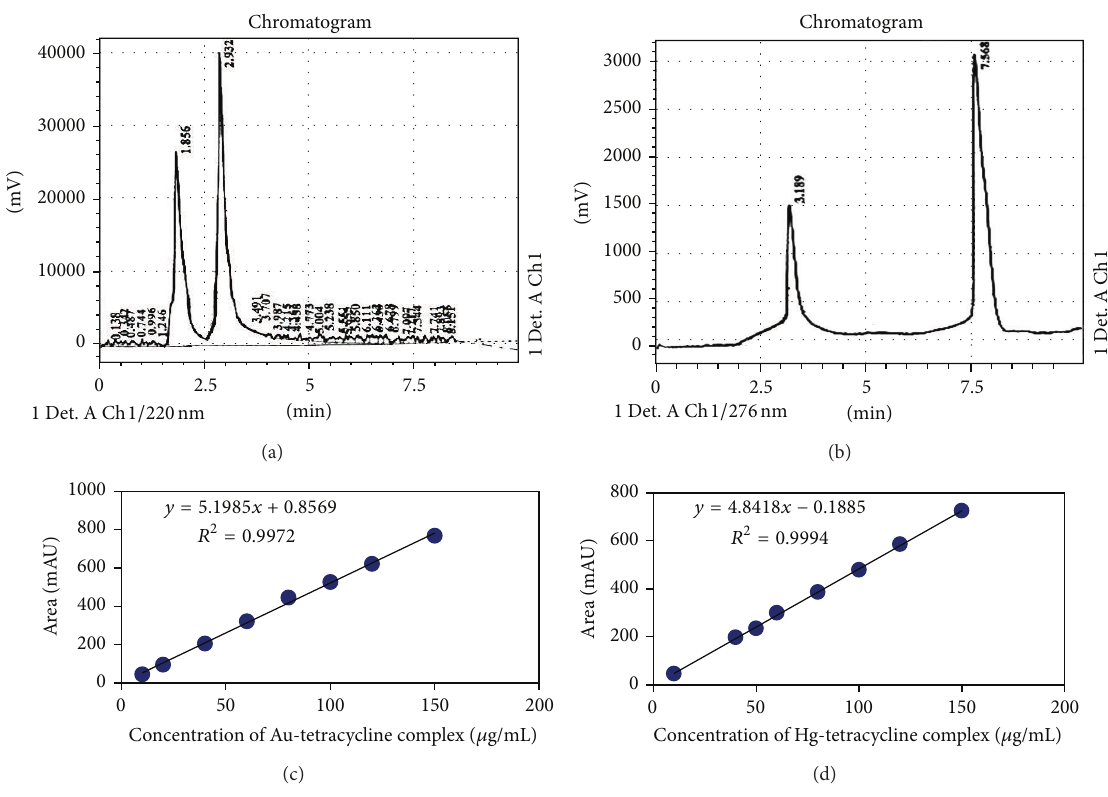
Figure 9: Upper: chromatograms of TC and its (a) Au(III) and (b) Hg(II) complexes with retention times (1.865, 2.932 min) and (3.189, 7.568 min), respectively, at detection 𝜆 max 220 and 276 nm, respectively. Lower: direct calibration curves for the determination of TC-Au(III) and TC-Hg(II) complexes by HPLC method.